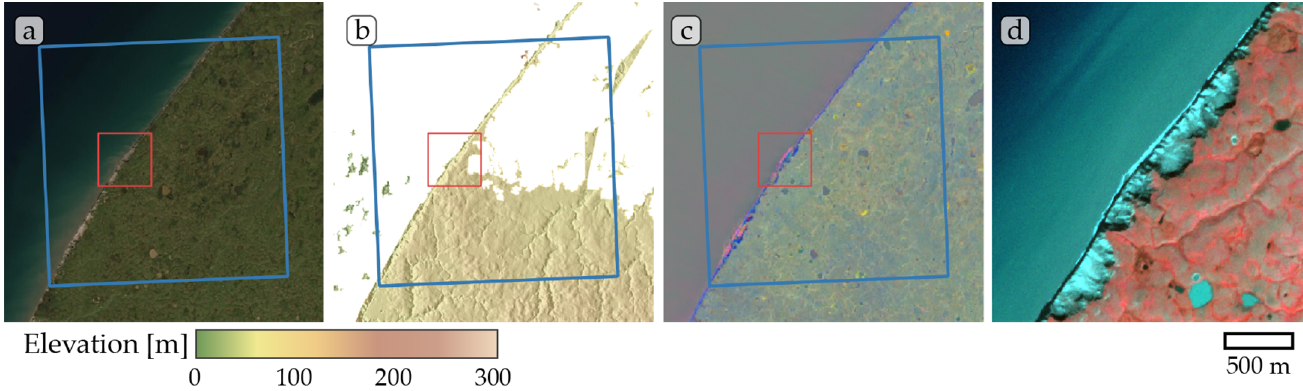
Figure A6. Study site Kolguev Island 01. ( a ) ESRI satellite layer, ( b ) ArcticDEM superimposed with hillshade, ( c ) Tasseled Cap trend visualization, ( d ) PlanetScope satellite image (NIR-R-G) acquired on 22 August 2019. Blue box, 10 × 10 km study site. Red box detailed view of ( d ). Note partially missing ArcticDEM data in ( b ).